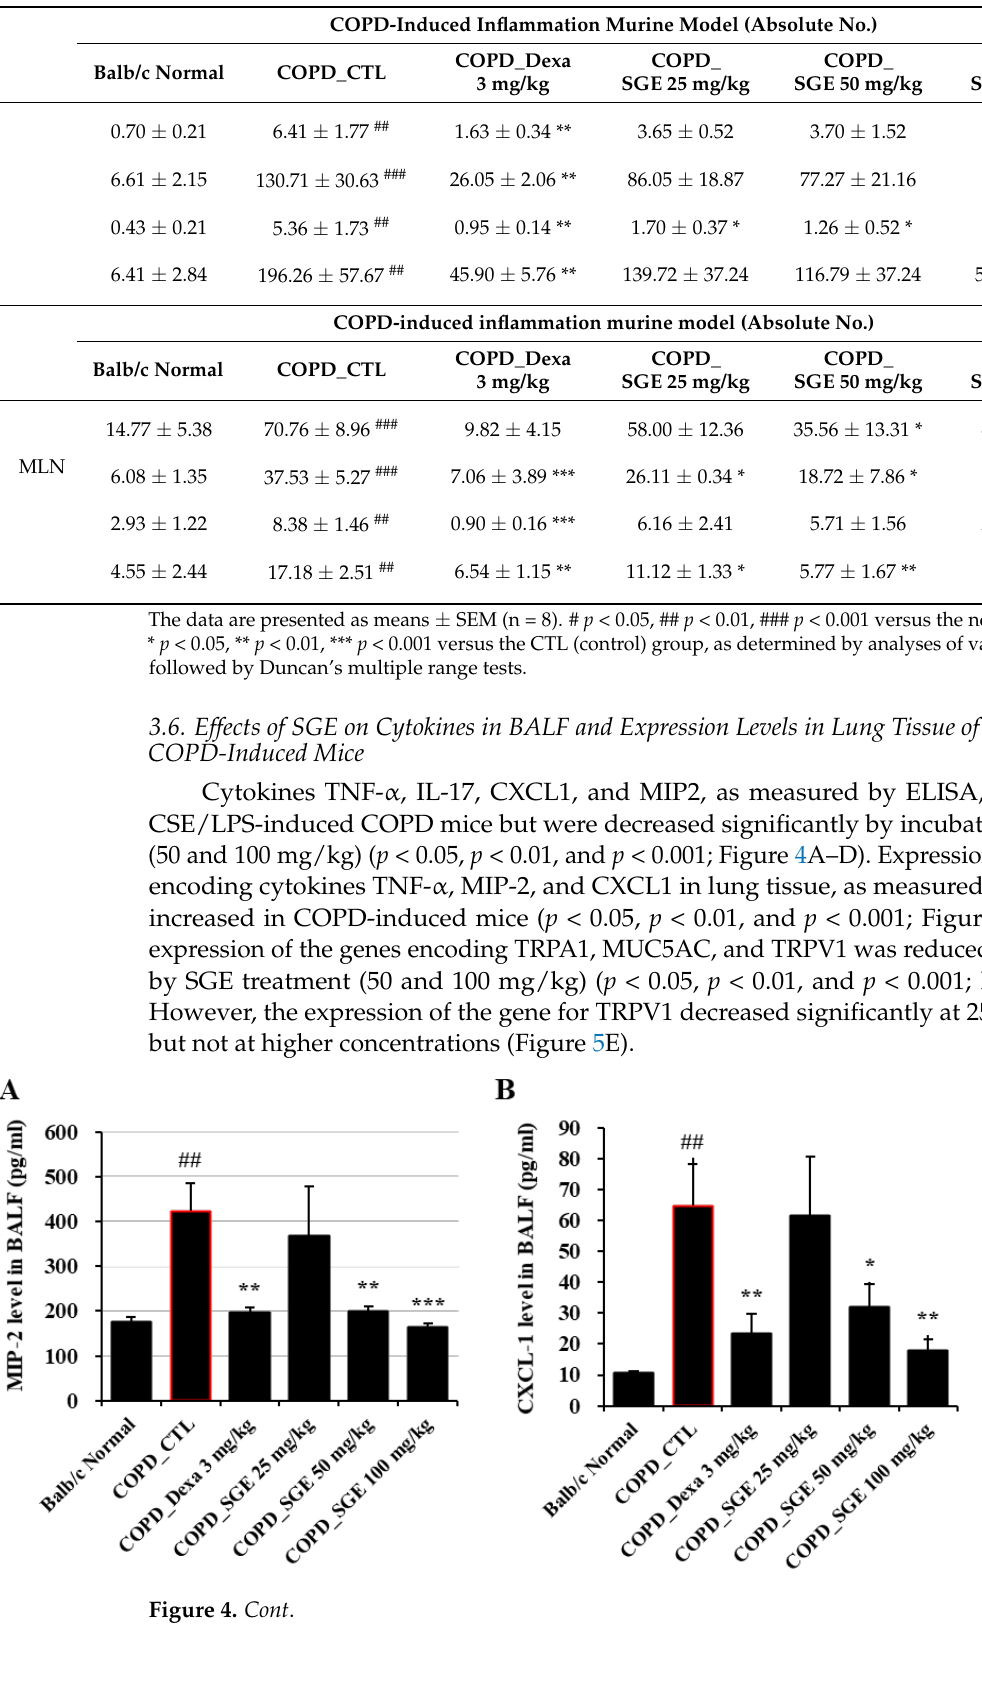
Figure 4. Effects of SGE on cytokine production in BALF of COPD-induced mice . Production of ( A ) MIP2, ( B ) CXCL1, ( C ) IL-17, ( D ), and TNF- α in BALF of COPD -induced mice was measured by ELISA. The data are presented as means ± SEM (n = 6 mice) for individual mice. ## p < 0.01, ### p < 0.001 compared to normal, and * p < 0.05, ** p < 0.01, and *** p < 0.001 compared to control. Dexa, dexamethasone.